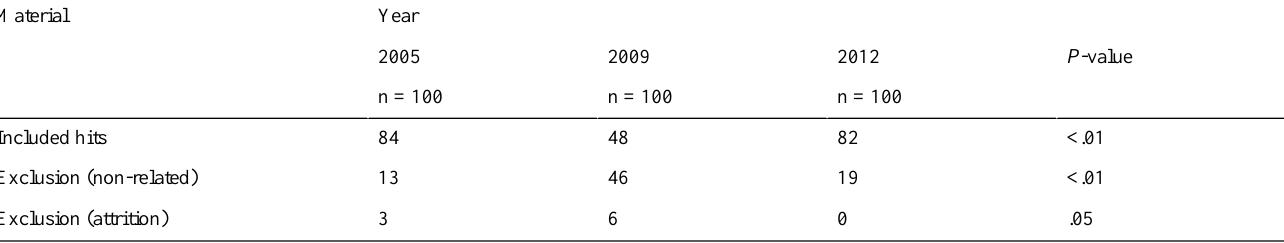
Table 1. Included suicide-related content, exclusion due to relevance, and attrition in 2005, 2009 and 2012 respectively. P -values based on Fisher’s exact